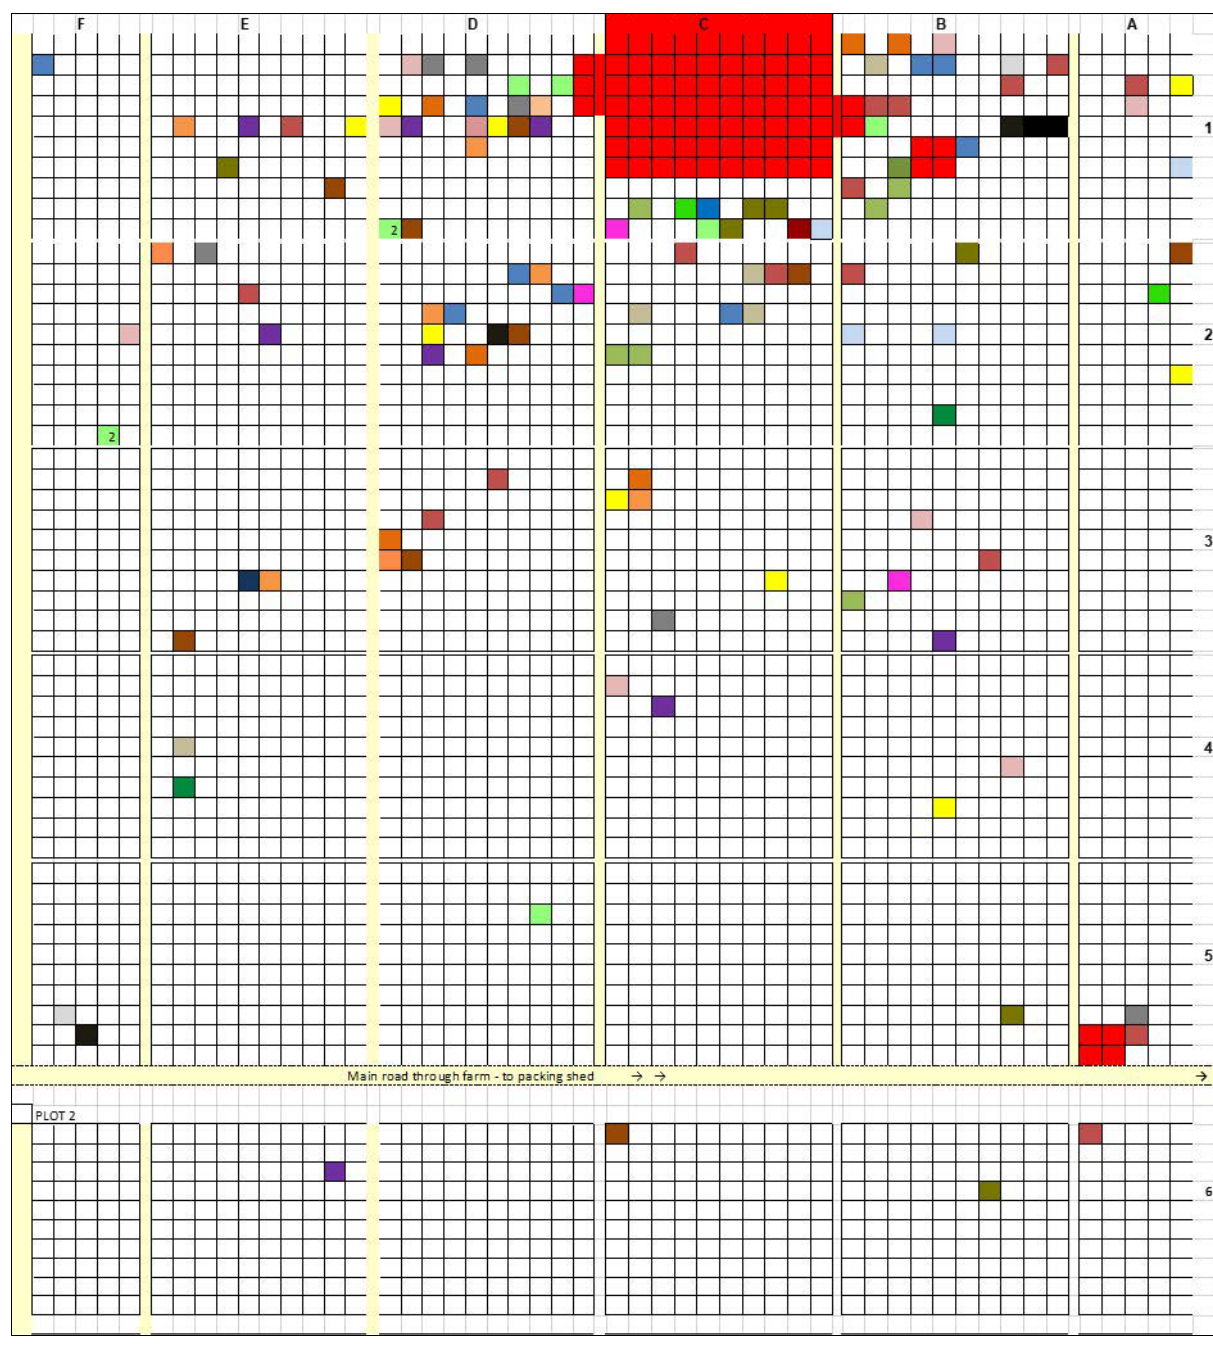
Figure 4: An illustration of the spread of Fusarium oxysporum f. sp. cubense tropical race 4 at Lurio farm in northern Mozambique by July 2015. Each block represents 1 ha, and each colour indicates a different week. The yellow lines are farm roads. The red blocks indicate the areas where banana Fusarium wilt TR4 was first detected, whereafter production in block C1 was